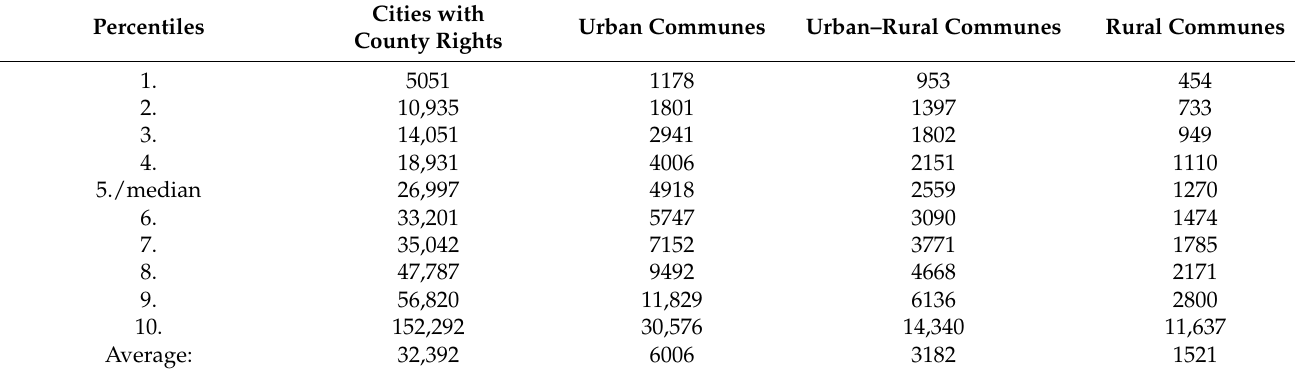
Table 11. Percentiles and the average population of the revitalisation area in the respective types of the communes in (pers). Cities with Percentiles County